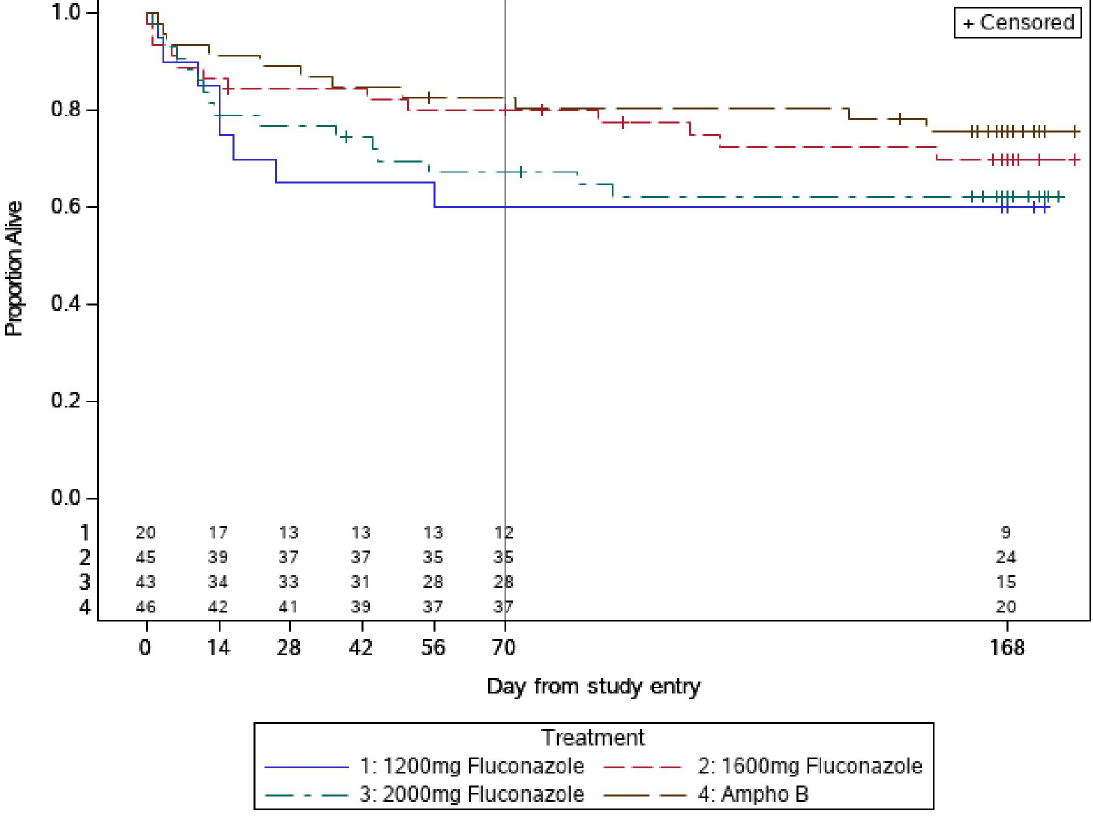
Fig 3. Time to death (safety